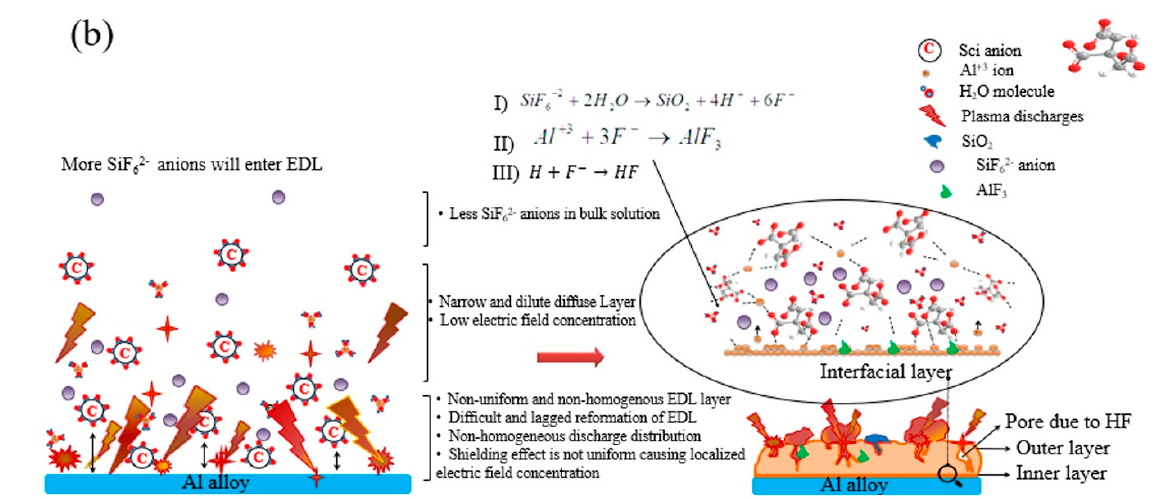
Figure 7. Schematic illustration showing the formation of the EDL as well as the hydrolysis reaction of SiF 62 − anions on the surface of the ( a ) S5 sample and ( b ) S10 sample.